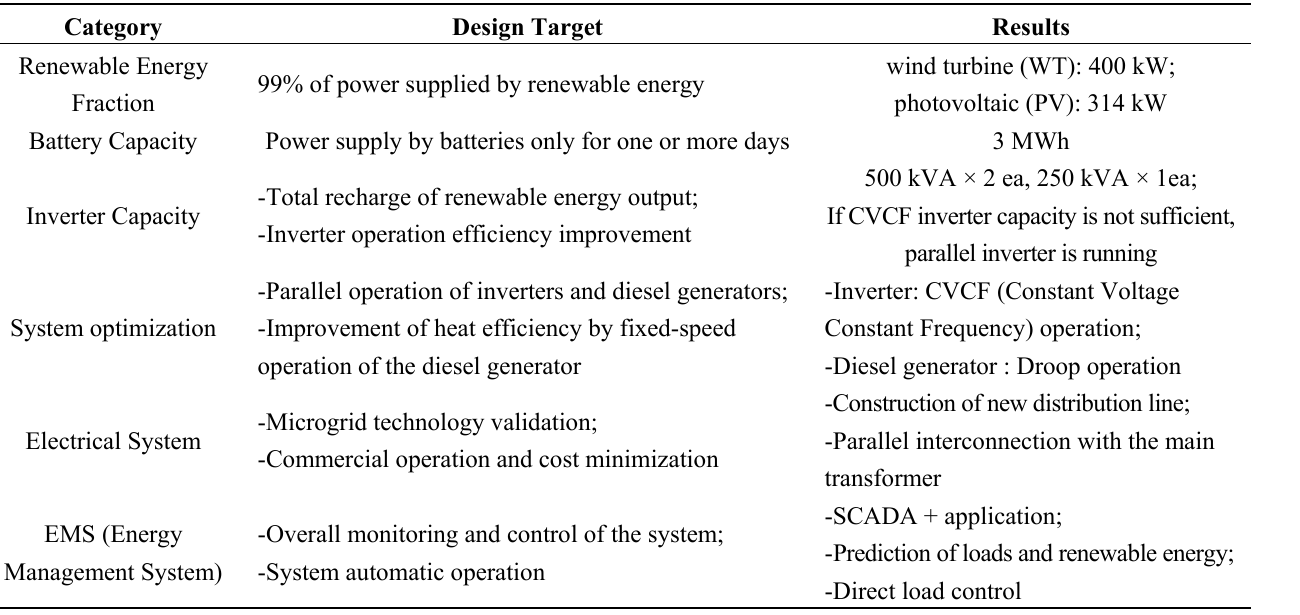
Table 4. Design target and design results for the test island